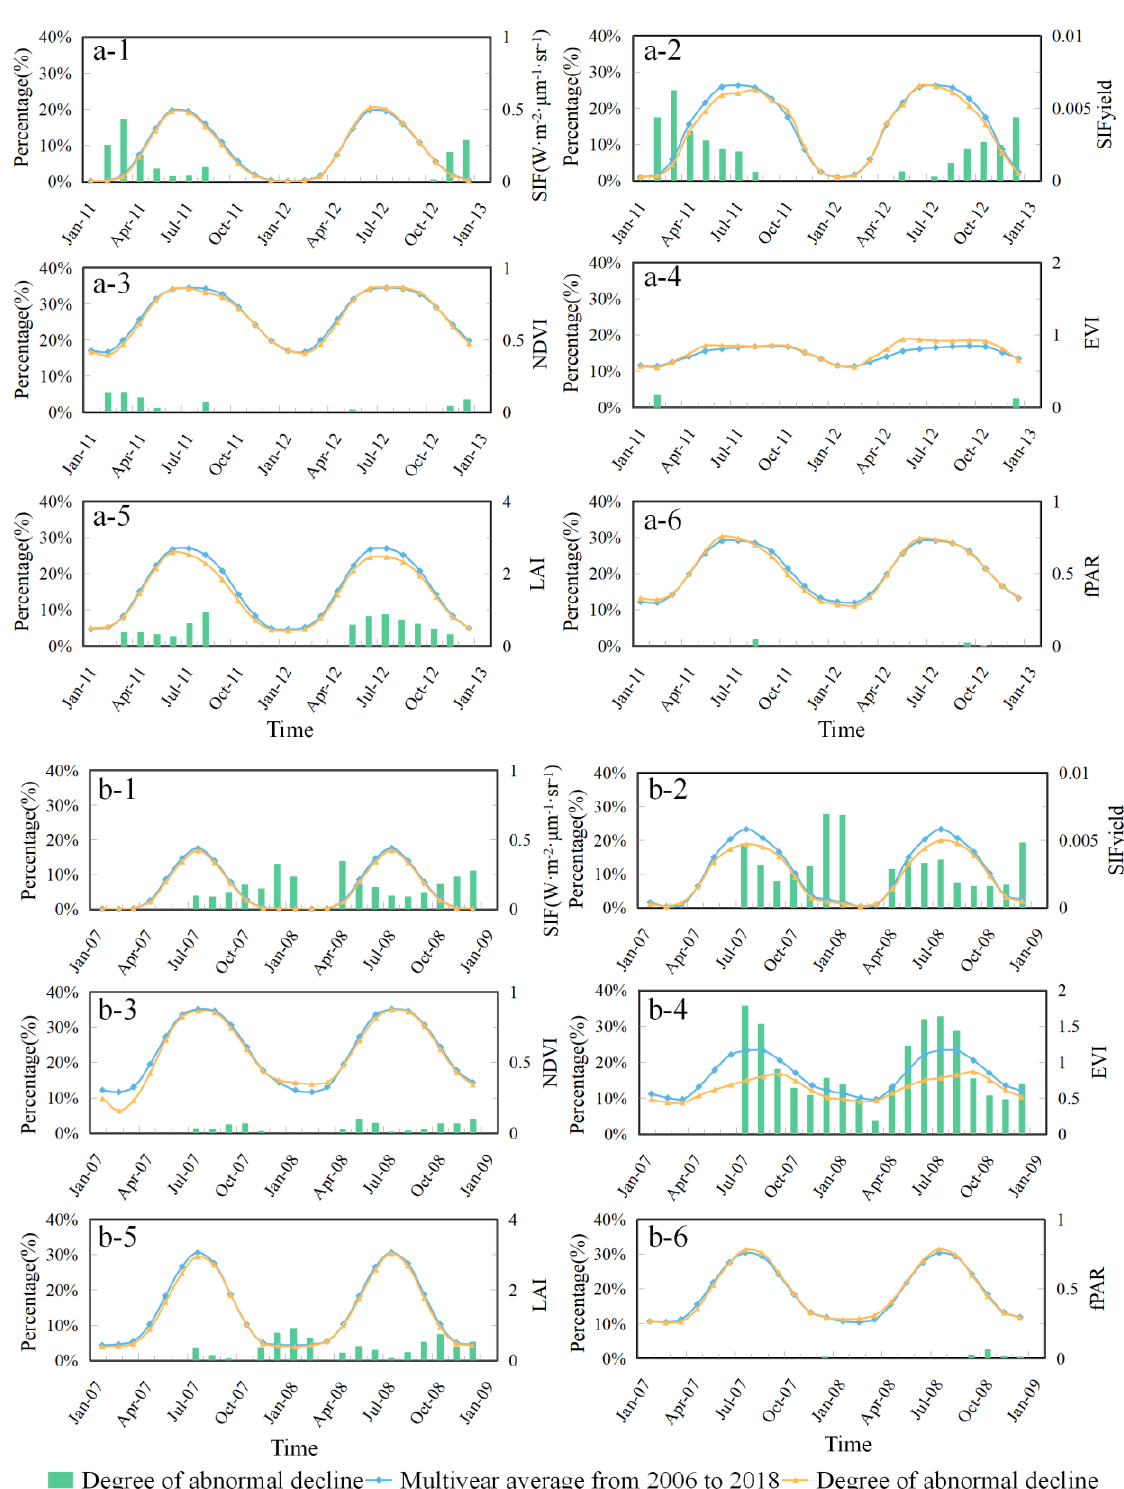
Figure 5. ( a1 – a6 ) The seasonal cycle variation curves of present values and multi-year averages and the abnormal decrease amplitude of the present values from the average values of SIF, SIFyield, NDVI, EVI, LAI, and fPAR, respectively, in Shaanxi province ( b1 – b6 ). The seasonal cycle variation curves of present values and multi-year averages and the abnormal decrease amplitude of the present values from the average values of SIF, SIFyield, NDVI, EVI, LAI, and fPAR, respectively, in Heilongjiang province.